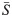
Rdiv predicts the response of incidence to reductions of the transmission rate.(A) Interventions that push the system below the threshold are effective at stopping the accumulation of new genes, whereas those that do not, result in the rebound and rebuilding of diversity (A). Light and dark grey colors indicate genes that originate respectively before and after the intervention. Reductions of transmission rates would result in decreased Rdiv values (B) and increased S¯ (C) to different levels. (C) When Rdiv remains above 1, prevalence and Multiplicity of Infection (MOI) rebound relatively fast, whereas they do not recover when Rdiv drops below 1. Changes in these epidemiological quantities, prevalence and MOI, cannot per se indicate this transition, as they change continuously with different levels of intervention and do not exhibit a threshold.